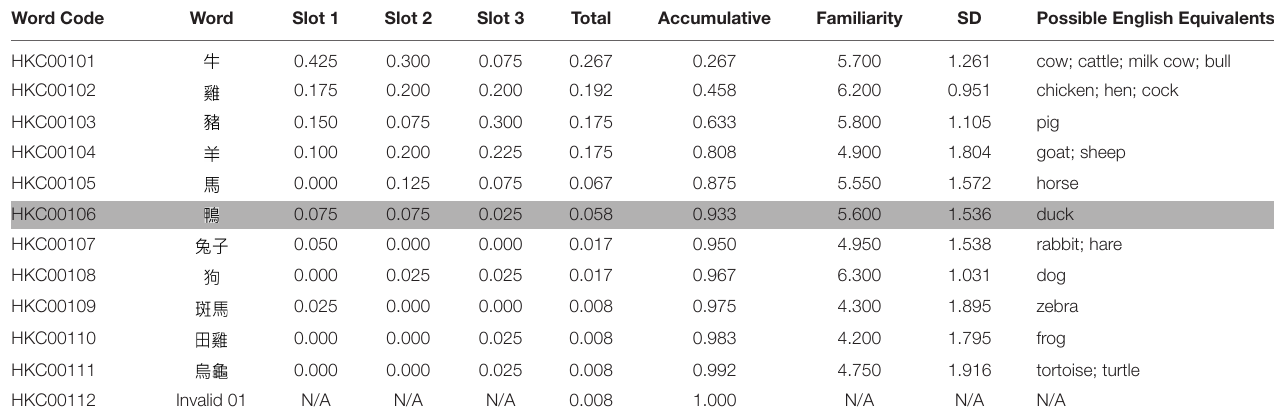
TABLE 1 | Category of “a farm animal”